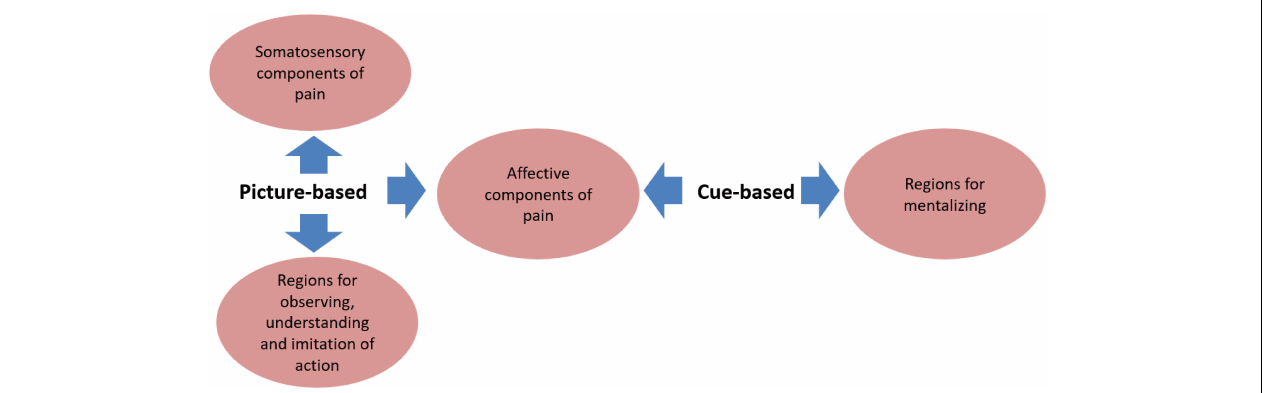
FIGURE 2 | Common and distinct brain areas associated with the two paradigms. The common neural network activated in both picture-based and cue-based paradigms is the affective components of the pain matrix including the AI and MCC/ACC. Picture-based paradigms trigger distinct responses in somatosensory regions of pain including S1 and S2, and some brain areas for action observing, understanding and imitation including the ventral premotor cortex and the anterior inferior parietal cortex. While cue-based paradigms uniquely activate regions for mentalizing including the precuneus, temporo-parietal junction (TPJ), ventral parts of medial prefrontal cortex (mPFC), posterior superior temporal cortex, and temporal